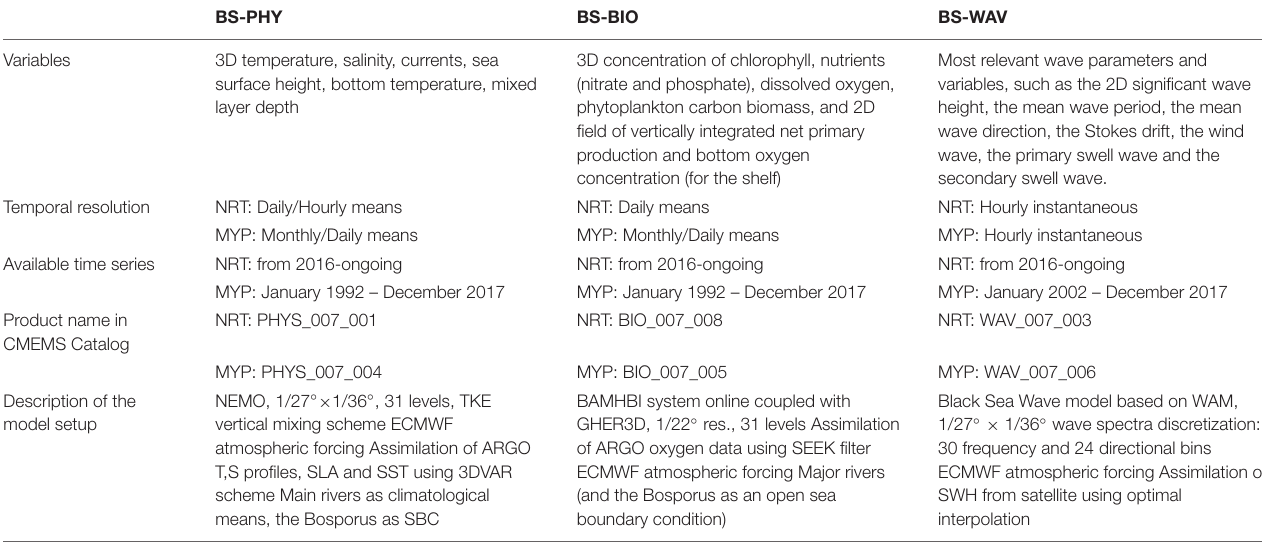
TABLE 1 | CMEMS BS-MFC operational